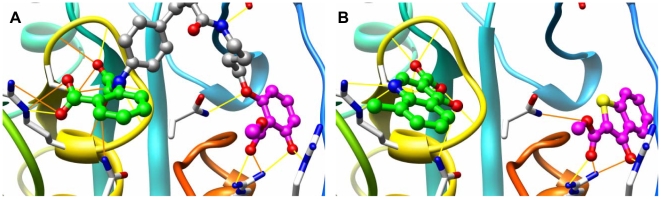
Top ranked fragments from the virtual screen mimic portions of a known potent PTP1B inhibitor.(A) A co-crystallized ligand (stick) is shown bound to PTP1B (1ph0), and extends across both the catalytic and non-catalytic sites. The key hydrogen bonding interactions between the ligands and the binding site residues are illustrated with yellow lines. Different portions of the ligand are colored for comparison with the fragments in (B). (B) Two high-ranking fragments from virtual screening. One predicted heterocyclic carboxylic acid (carbon atoms colored green, rank 49) is shown bound to the PTP1B catalytic site, and one neutral methyl salicylate hit (carbon atoms colored magenta, rank 59) is shown bound to the non-catalytic site. Molecular images were generated with UCSF Chimera [42].